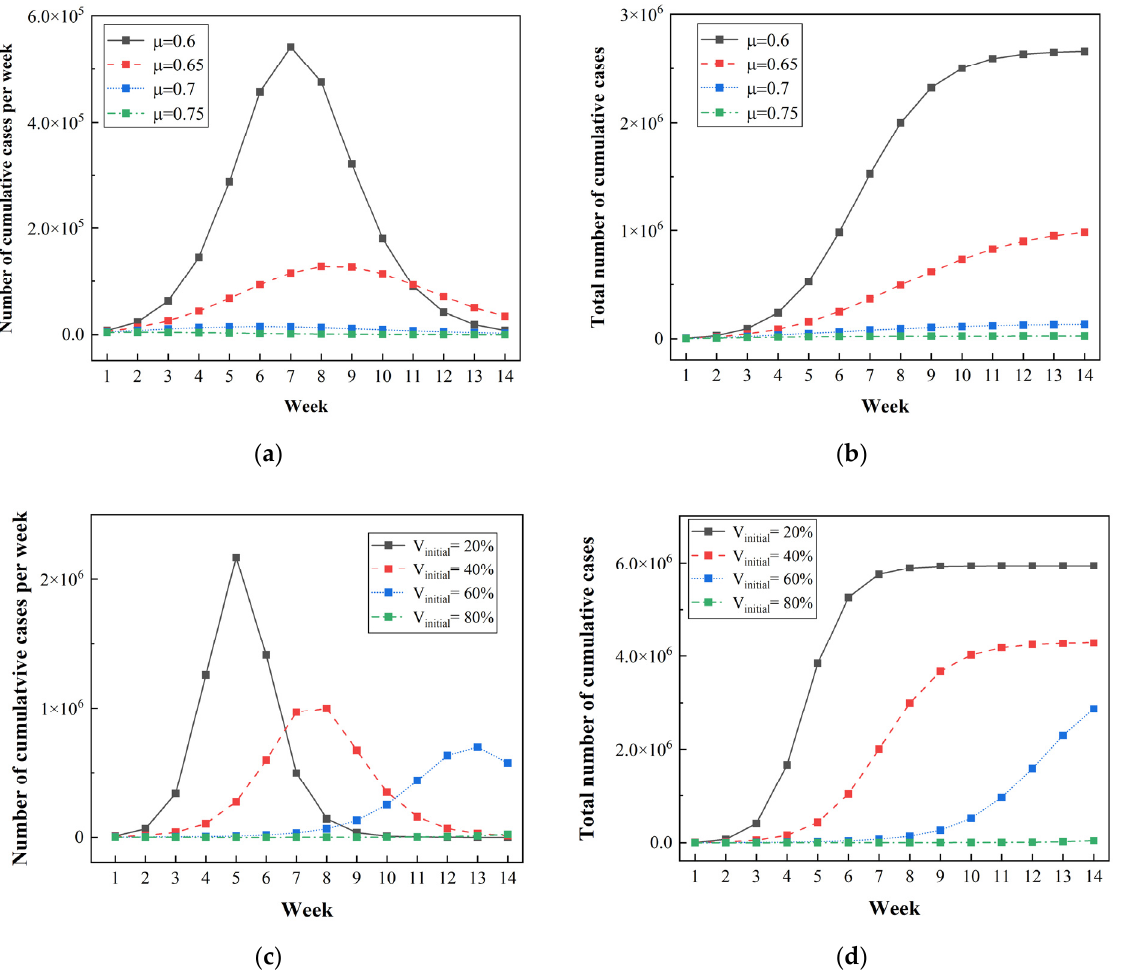
Figure 11. Simulated results under the implementation of different quarantine and vaccination measures during the spread of the Omicron variant: ( a ) The cumulative number of cases per week under different quarantine measures; ( b ) the total number of cases under different quarantine measures; ( c ) the cumulative number of cases per week under different vaccination measures; ( d ) the total number of cases under different vaccination measures.